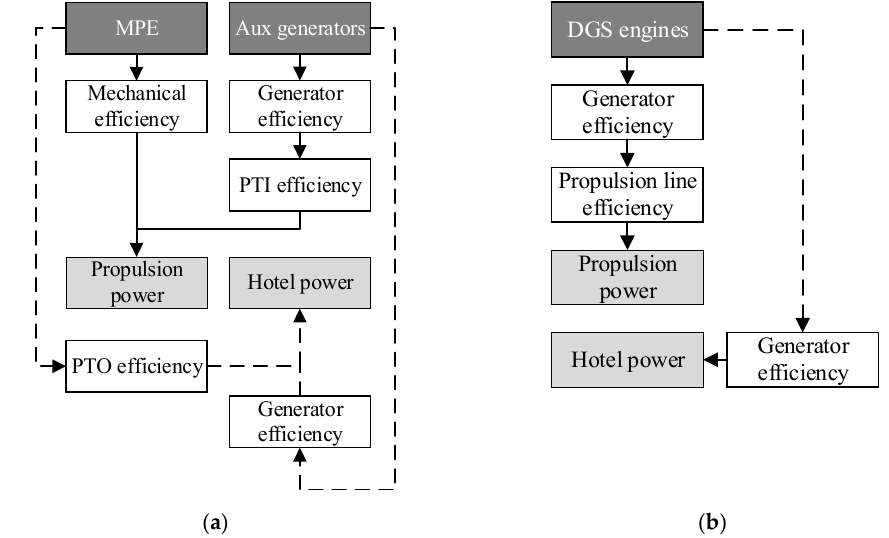
Figure 1. Power production alternatives and related losses in the power transmission from prime movers to the ship propeller: ( a ) mechanical propulsion; ( b ) diesel-electric propulsion .